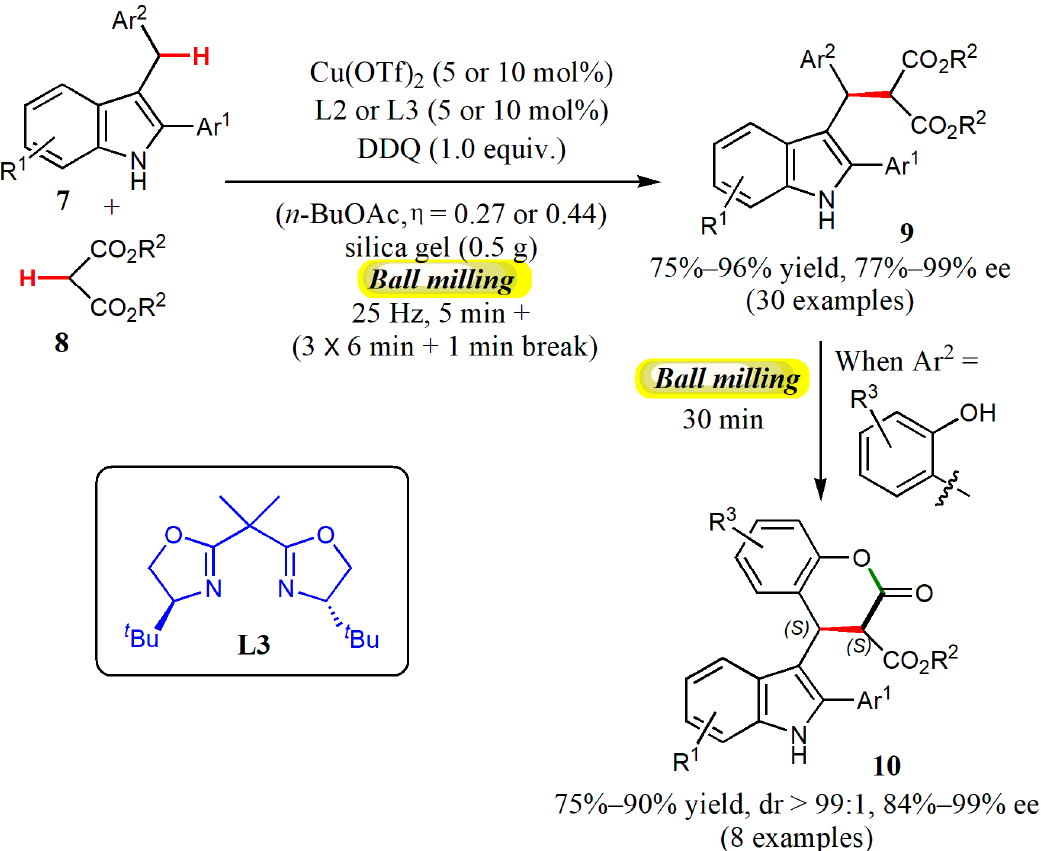
Figure 4. Copper-catalyzed enantioselective CDC of benzyl indoles and malonates.